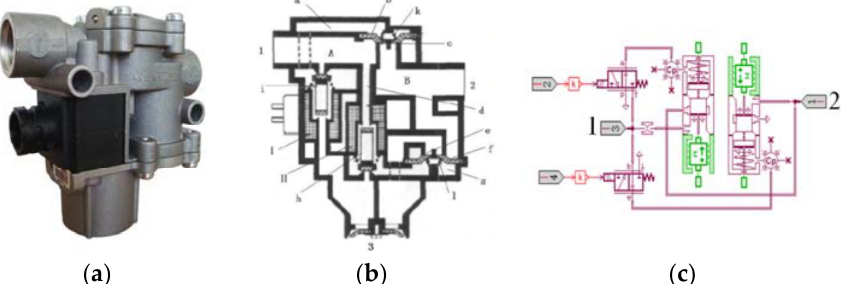
Figure 4. Pneumatic ABS solenoid valve. ( a ) Appearance. ( b ) Schematic diagram. ( c ) AMESim submodel. In the schematic diagram: 1-from braking valve; 2-to braking chamber; 3-to atmosphere; a-pilot chamber(inlet valve); b-inlet valve diaphragm; c-inlet valve seat; d-air pilot passage; e-exhaust valve seat; f-exhaust valve diaphragm; g-pilot chamber(exhausted valve); h-pilot exhaust solenoid